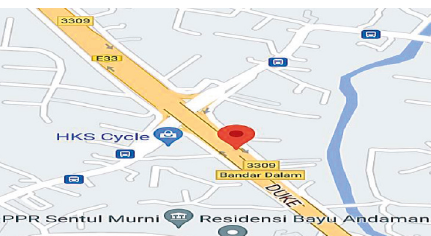
Figure 1: Data collection location (Duke Highway at Taman Selasih, Gombak,